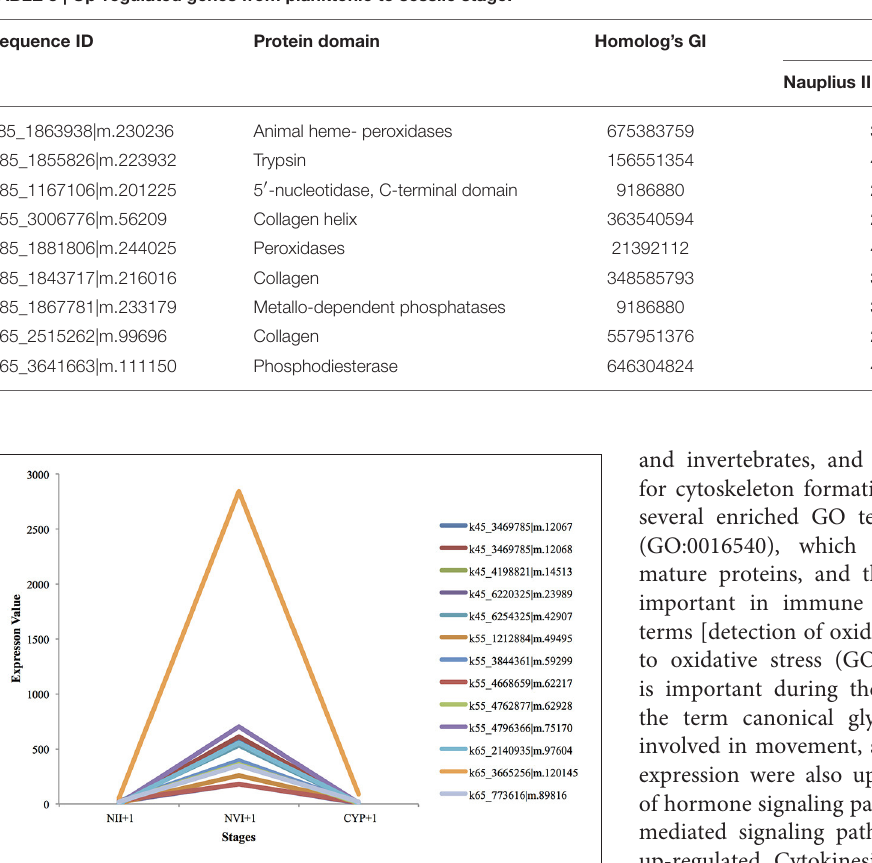
strongly up-regulated in the cyprid stage. Amongst these were adhesion functions, including leukocyte cell-cell adhesion (GO:0007159), and mature structure development as notum development (GO:0007477) ( Figure S5 and Table S1